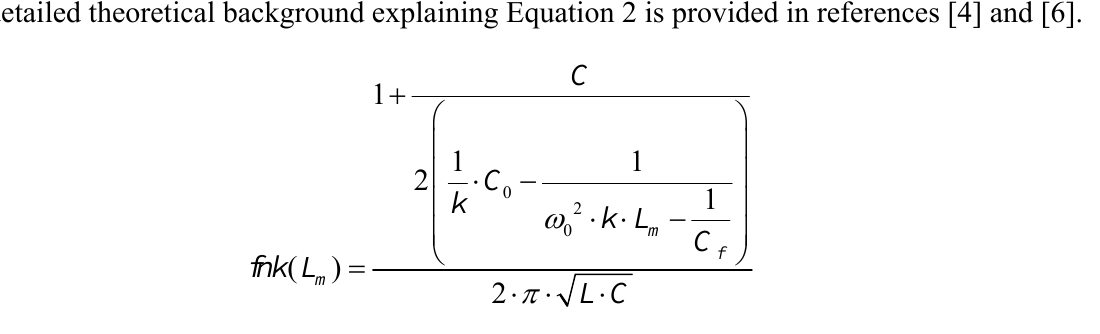
) for k = 0.5 and fn3 ( L m